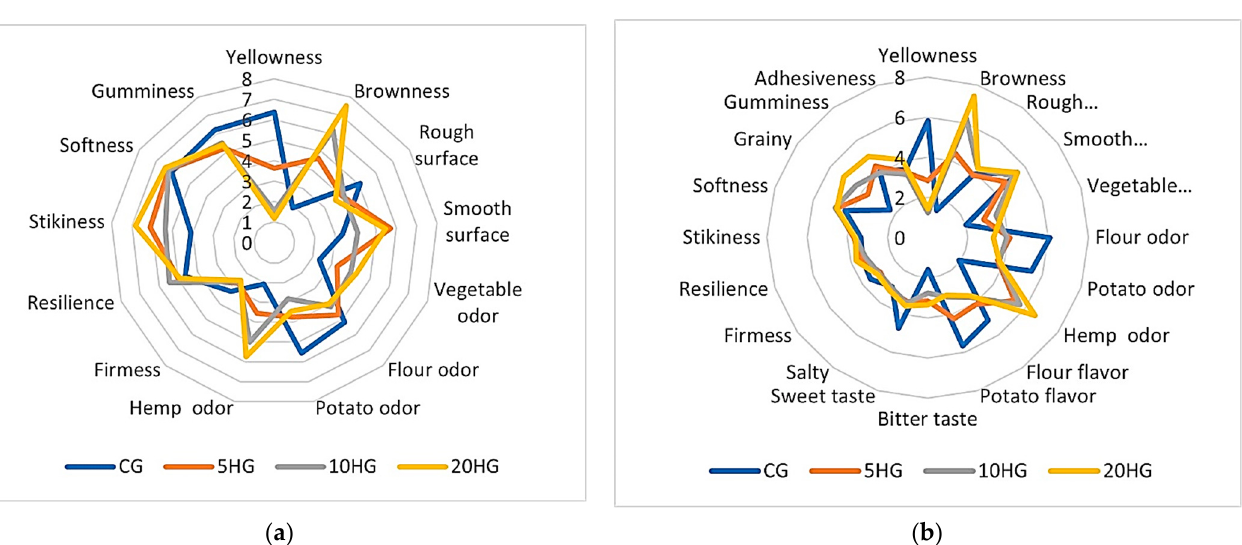
Figure 2. Combo chart representation of the hedonic consumer test for control and hemp seed flour- enriched gnocchi samples: ( a ) raw samples; ( b ) cooked samples.